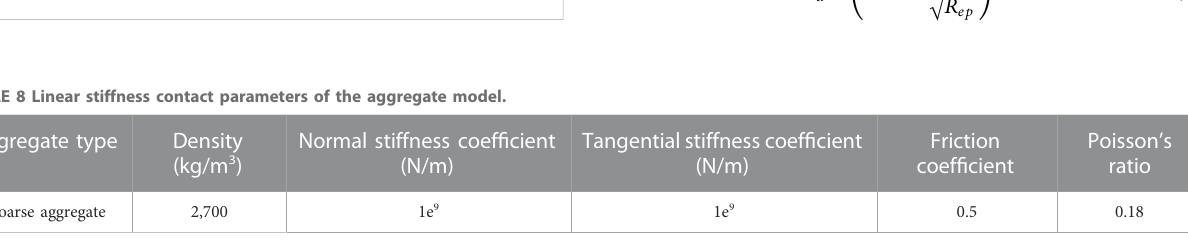
FIGURE 8 Cyclic computation process of two-way coupling of PFC-CFD. The PFC cycle advances at a time increment equal to the coupling time interval t c . The fl uid solver updates and sends (cid:1) v i , p i , (cid:1) ∇ p i , ρ i f , and μ i to PFC.